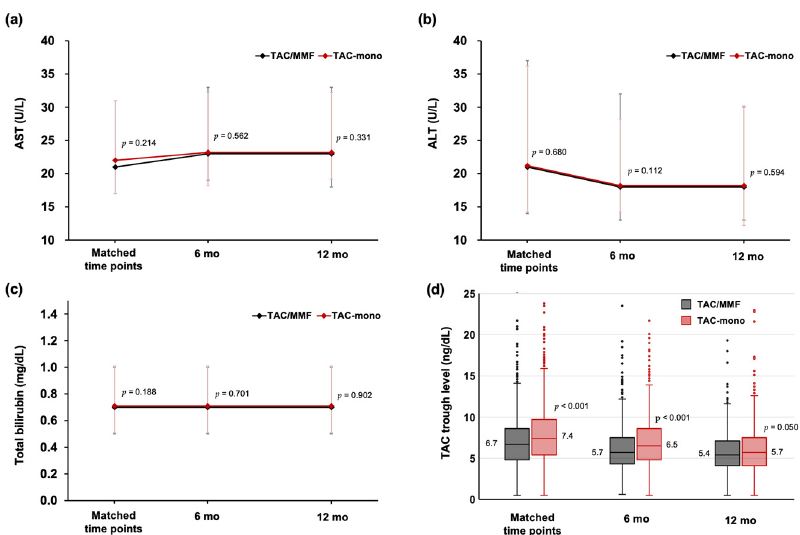
Figure 4. Comparison of liver function tests and tacrolimus trough levels between TAC/MMF and TAC-mono groups. Values of ( a ) AST, ( b ) ALT, ( c ) total bilirubin, ( d ) TAC trough level were compared at matched time points, six months and 12 months later. In the box-and-whisker plot (Figure 4d), horizontal lines in the boxes represent the median, and the box limits represent the interquartile range. The ends of the whiskers mean maximum and minimum values and dots mean outliers. MMF, mycophenolate mofetil; TAC,